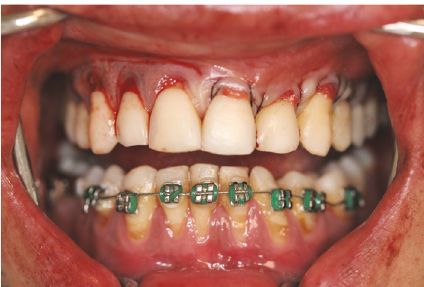
Figure 7: Stabilization and suture of the subepithelial connective